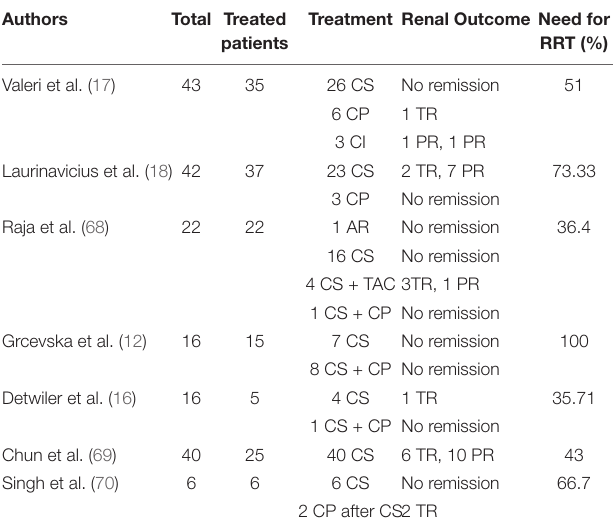
TABLE 2 | CG patients’ treatment and follow-up